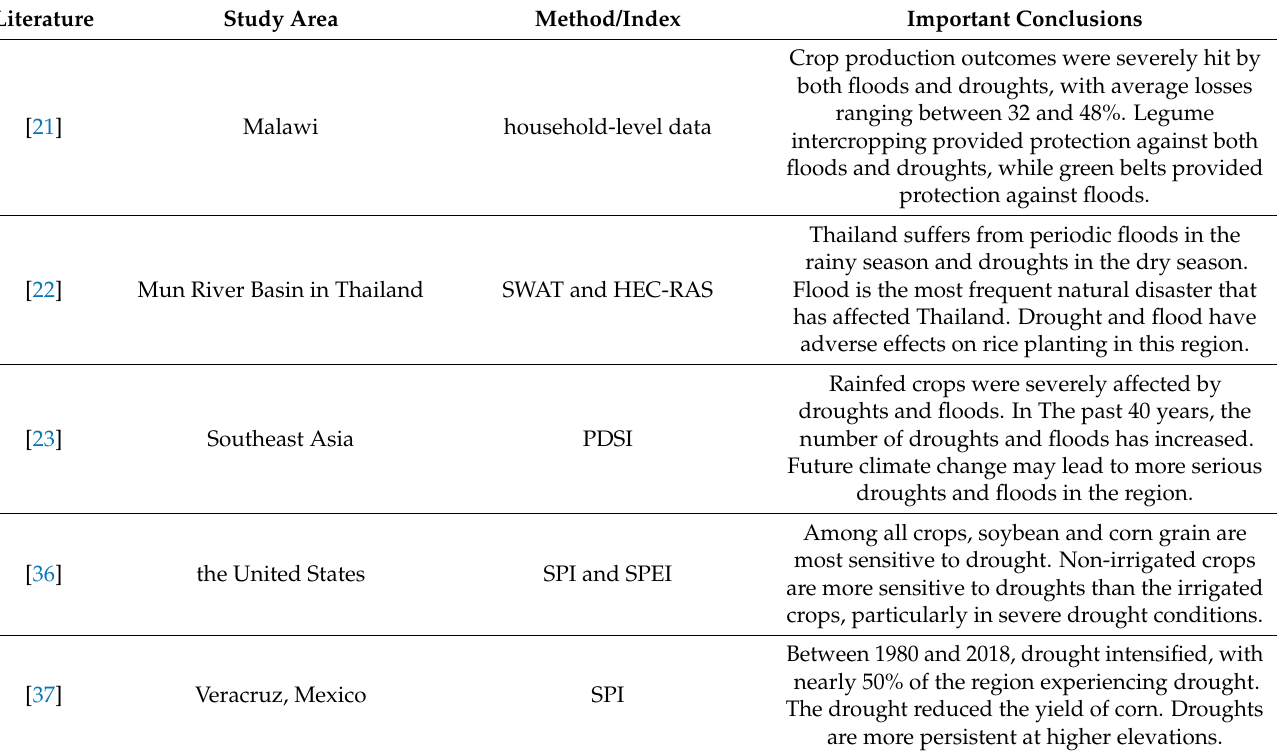
Table 7. Research status and important conclusions of drought or flood and their impact on